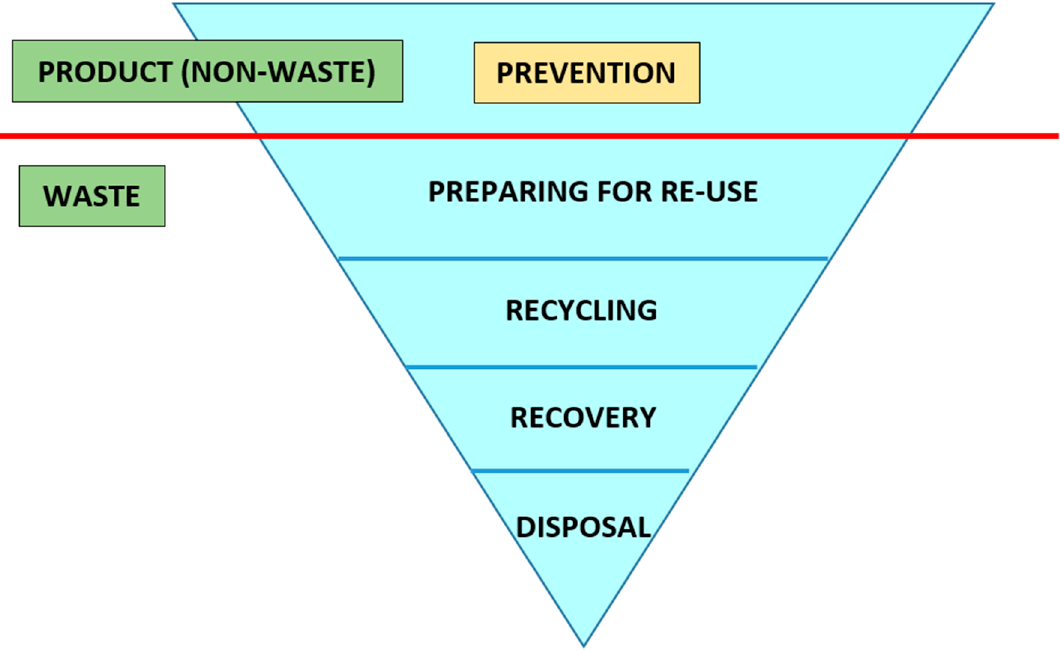
Figure 1. Waste management hierarchy in the EU.